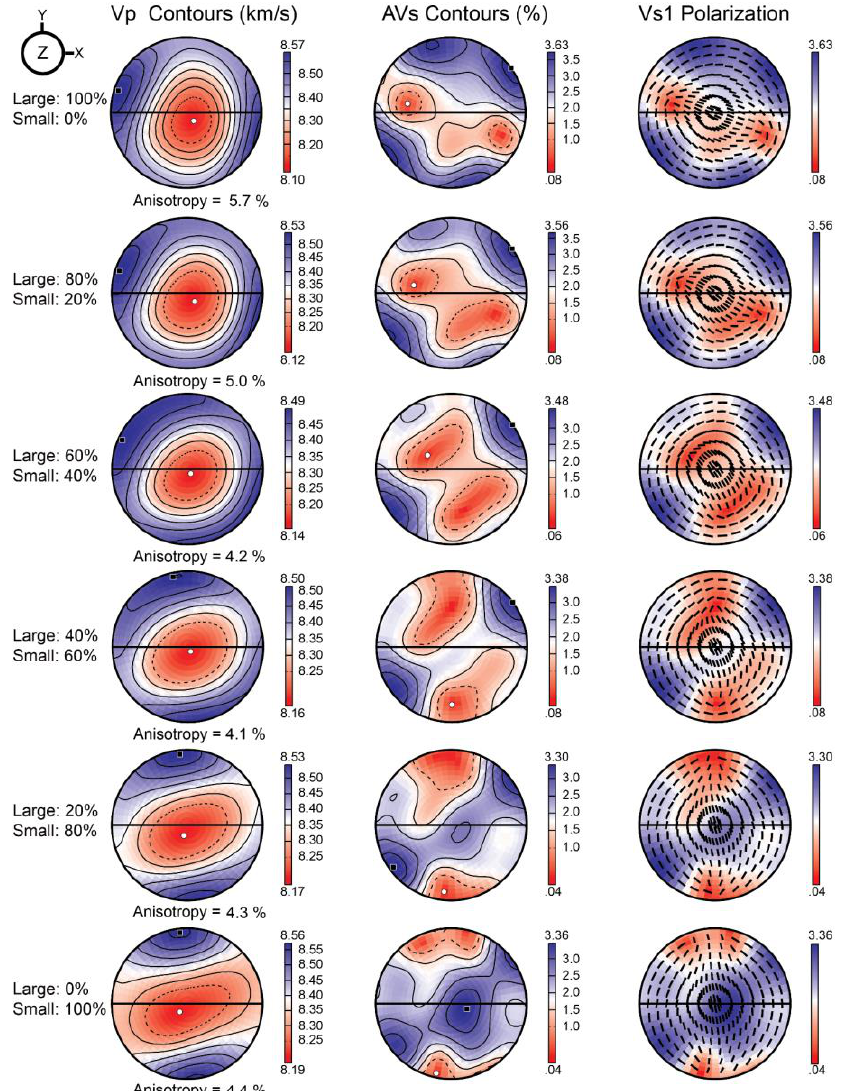
Figure 5. Effects of multiple stages of deformation on seismic velocity and anisotropy. LPO data of olivine from 448 large grains and 448 small grains (Figure 4C) was mixed with 6 different mixing ratios: 100:0, 80:20, 40:60, 60:40, 20:80, and 0:100. Seismic velocity and anisotropy are calculated from the mixed LPO data to estimate the e ff ect that the secondary deformation event had on the seismic anisotropy. The P-wave velocity (V P ), the amplitude of the shear-wave anisotropy (AV S ), and the polarization direction of the faster shear wave (Vs1) are plotted in the lower hemisphere using an equal-area projection. The center of the stereonet corresponds to the direction normal to the foliation (Z), and the east-west direction corresponds to lineation (X).